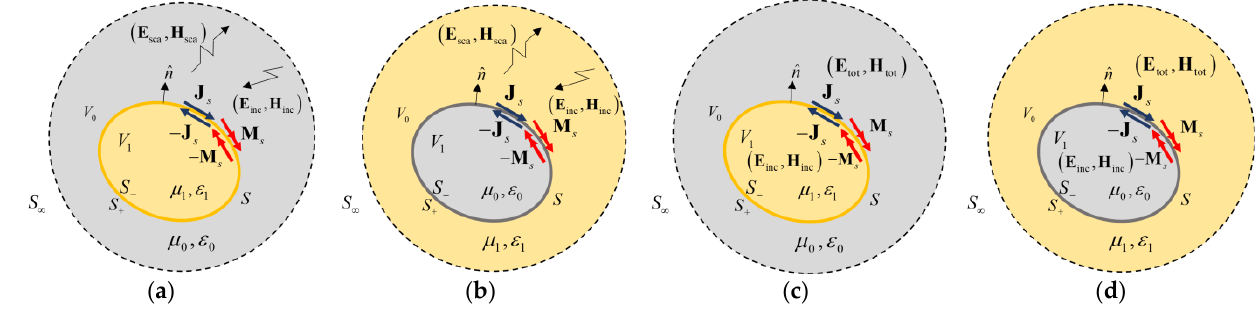
Figure 1. Illustration of scattering and radiation problems in reverse media. ( a ) Problem (A); ( b ) problem (B); ( c ) problem (C); ( d ) problem (D).